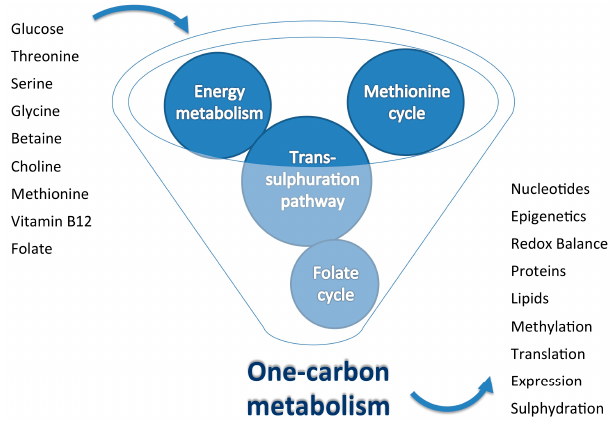
Figure 3. Schematic representation summarizing the importance of appropriate equilibrium in inputs and outputs of one-carbon metabolism. Excessive intake of a given nutrient influences the availability of other nutrients and can perturb metabolism with deleterious consequences. Understanding the events linking metabolism and diet-dependent pathways may provide crucial insight into their role in health and disease.